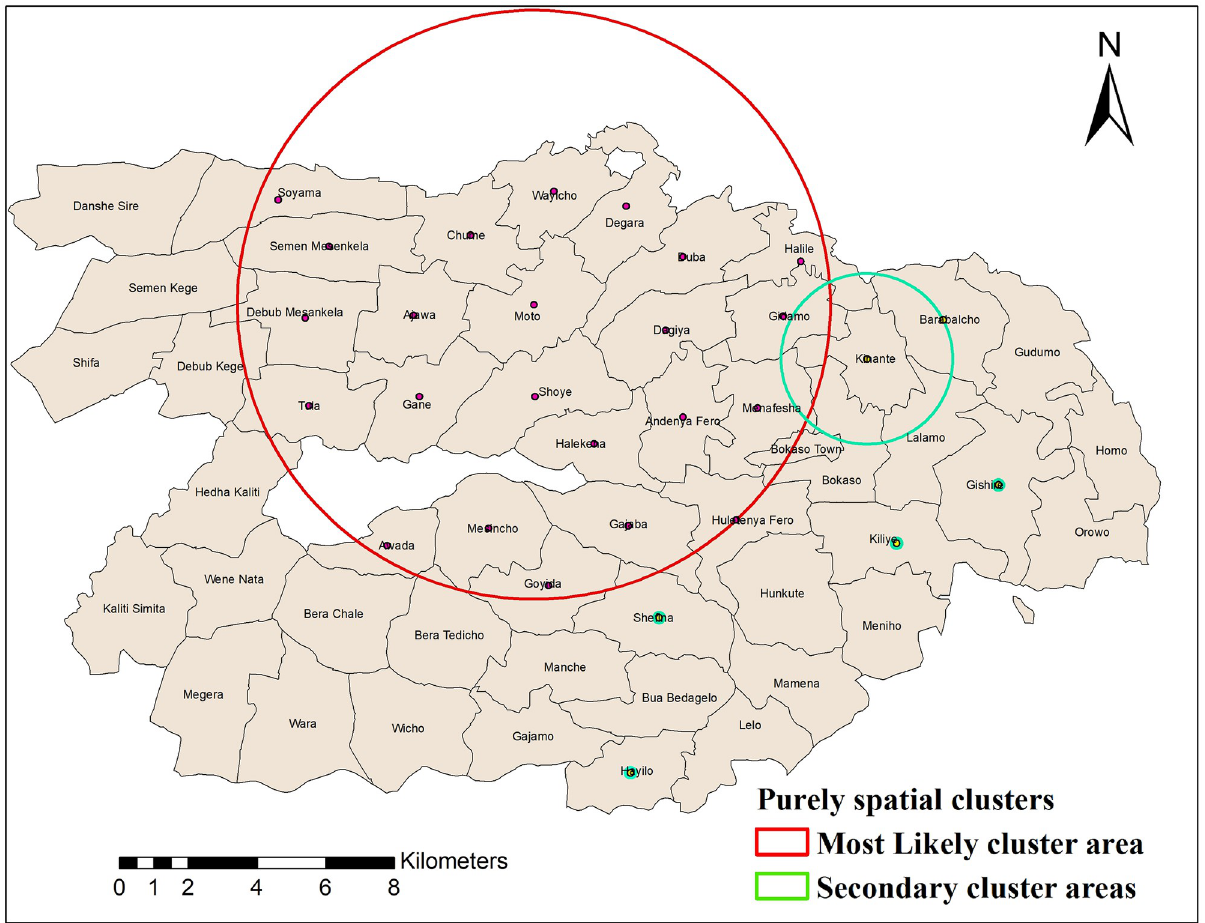
Fig 5. Covariate adjusted spatial clustering of low health service utilisation in Dale district, Sidama, Ethiopia, 2017/18.